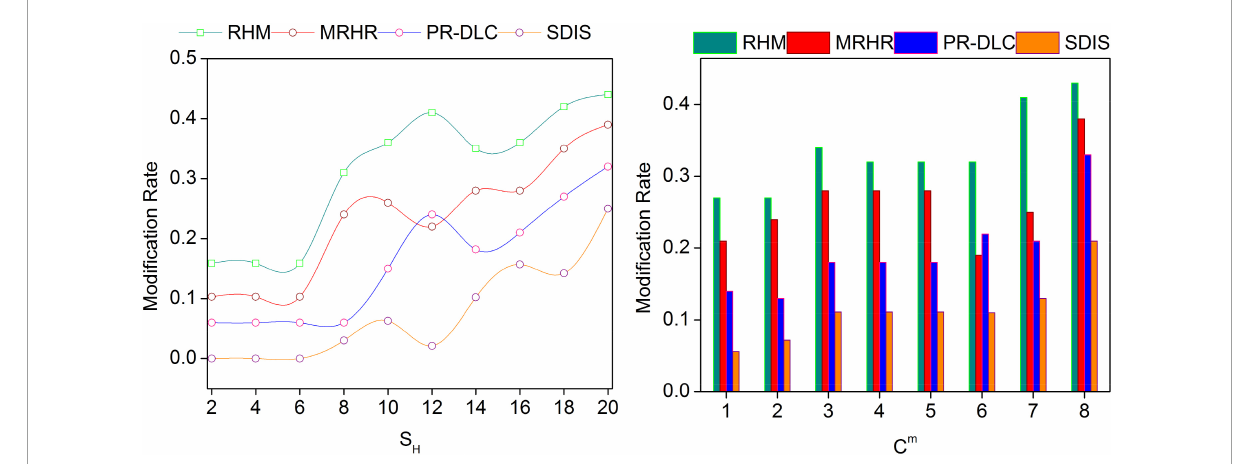
FIGURE8 Modification rate